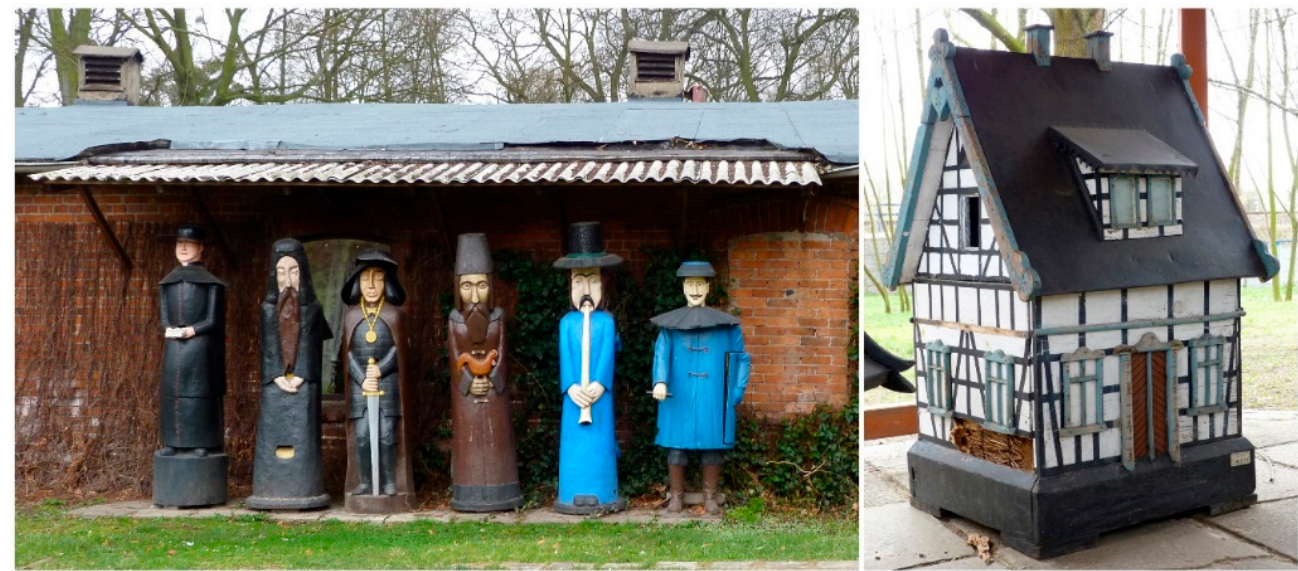
Figure 2. Wooden relics from the collection of The Museum of Apiculture in Swarz ę dz, a branch of The National Museum of Agriculture and Food Industry in Szreniawa, Poland; from the left: a set of figural beehives and an example of an architectural beehive (No. MS E-111).